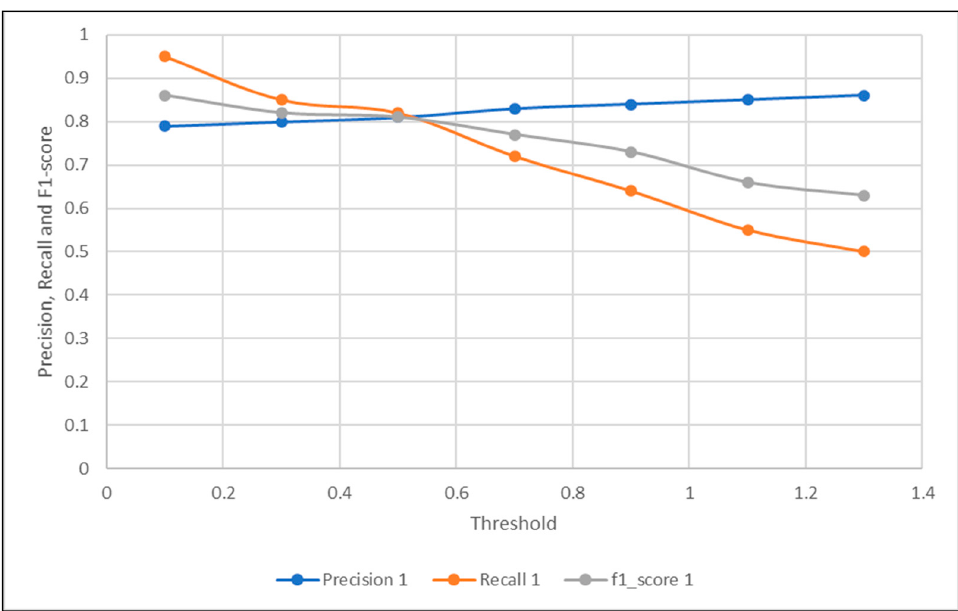
Figure 4. Optimal Threshold Selection Using Signal Difference Based on Correlation Complement.